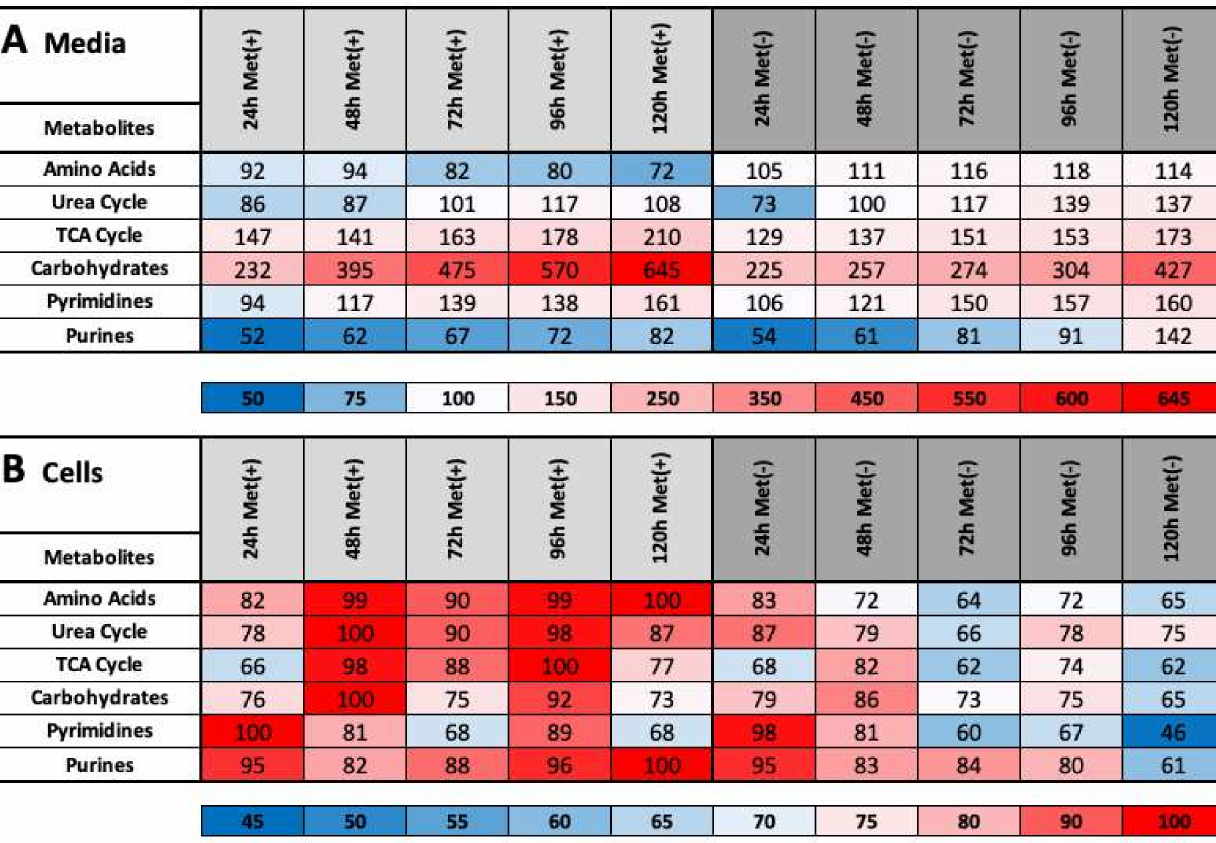
Figure 3. ( A , B ) Heat map overview of the summarized metabolites belonging to various classes and associated with various pathways in cell pellets and media. The percentages of the metabolites classified as amino acids, carbohydrates, pyrimidines and purines and belonging to the urea and TCA cycle pathways in media ( A ) and cells ( B ) were calculated as described in the Materials and